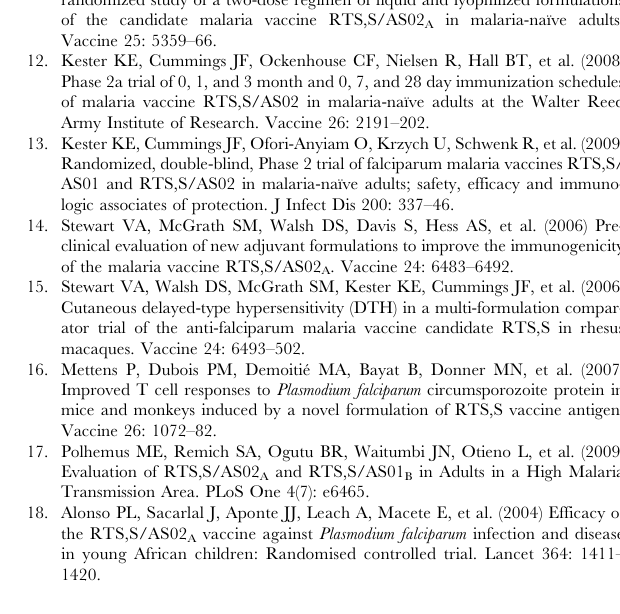
Table S1 CSP 3D7/non 3D7 type by polymorphic amino acid site in Th2r (single + majority) (ATP cohort for efficacy)